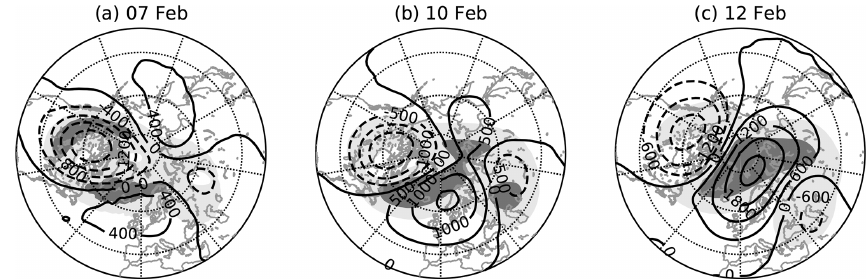
Figure 5. ERA-I 10hPa geopotential height anomalies (contours, m ) with respect to the 1980–2010 climatology and ensemble spread of geopotential height predicted for (a) 7, (b) 10 and (c) 12 February 2018 (shaded lightly and heavily for 0.3–0.6 values and values greater than 0.6, respectively). The spread has been normalized by the minimum and maximum values within the domain north of 20 ◦ N.